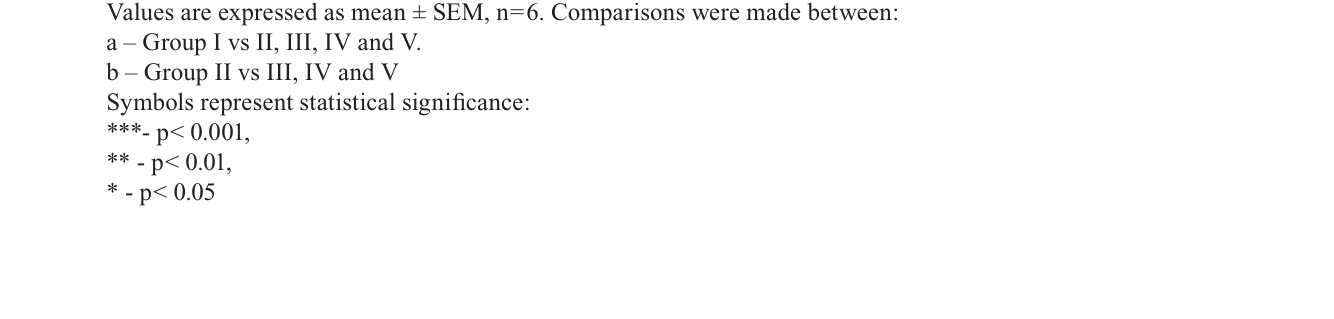
Values are expressed as mean ± SEM, n=6. Comparisons were made between: